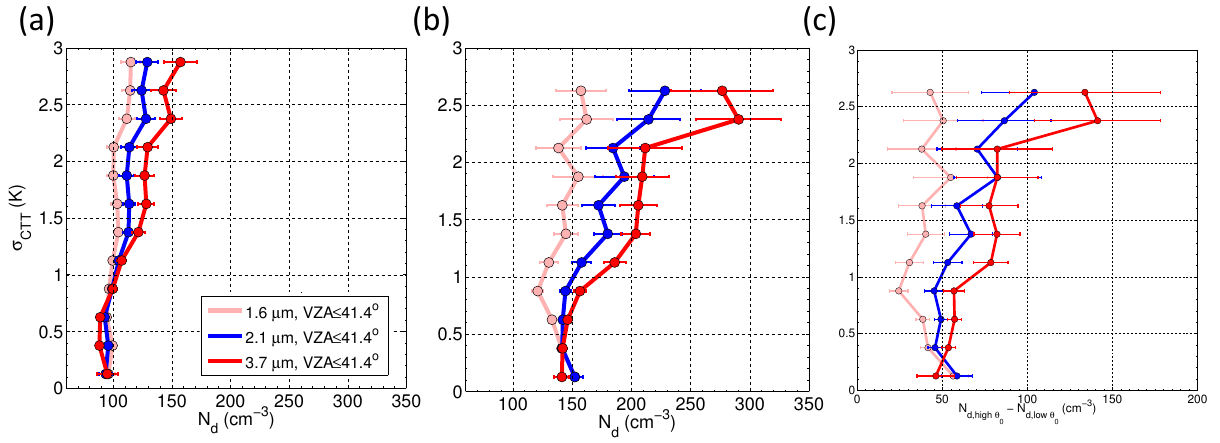
Figure 16. As for Fig. 15 except for droplet number